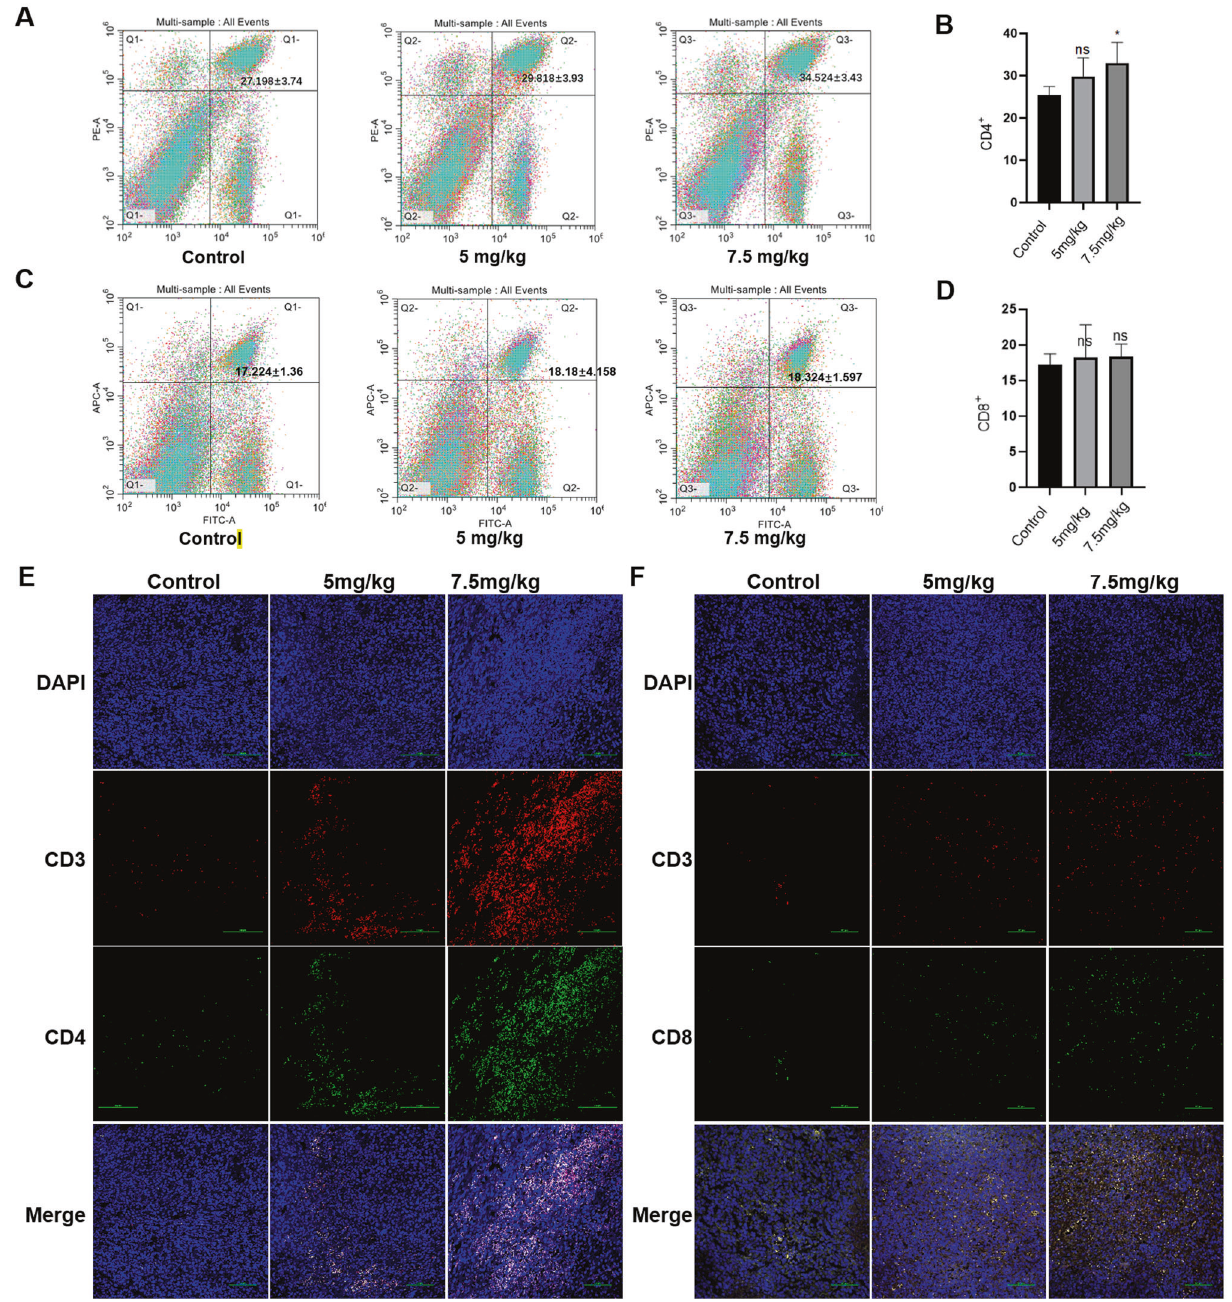
Fig. 4 TS promoted the immune regulation of H22 tumor bearing mice. A The proportion of CD4 + T cells in the spleen of tumor bearing mice were detected by fl ow cytometry. B The analysis of the results from A . C The proportion of CD8 + T cells in the spleen of tumor bearing mice were detected by fl ow cytometry. D The analysis of the results from C . The in fi ltration of CD4 + ( E ) /CD8 + ( F ) T cells in tumor tissue sections were detected by immuno fl uorescence (20×). Results are from independent duplicate or triplicate experiments and presented as means ± SD. Number of mice per group are seven ( n = 7). * p < 0.05 vs. the Control group; ** p < 0.01 vs. the Control group; *** p < 0.001 vs. the Control